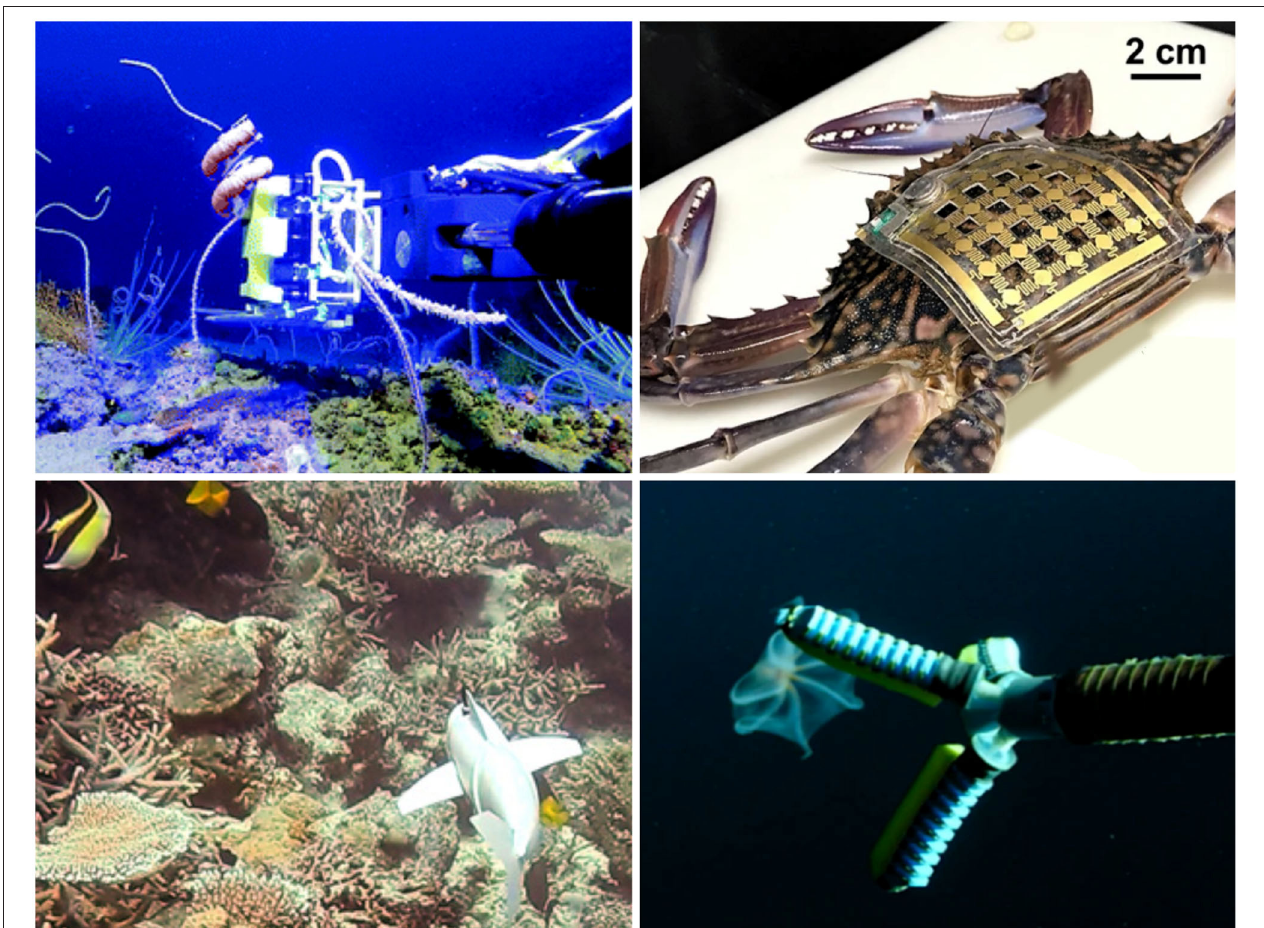
FIGURE 1 | Real word deployment of soft systems, i.e., settings where highly biodegradable elastomers can be employed. The image shows two different designs of soft robotics grippers for delicate sampling (Galloway et al., 2016-top right- and Phillips et al., 2018 -bottom right-), compliant marine sensory skin (Nassar et al., 2018), an underwater soft fish robot (Katzschmann et al.,